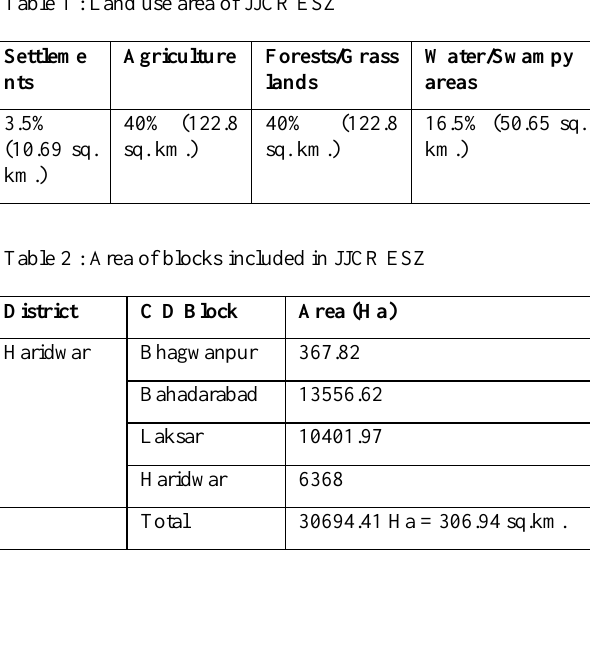
Table 1 : Land use area of JJCR ESZ